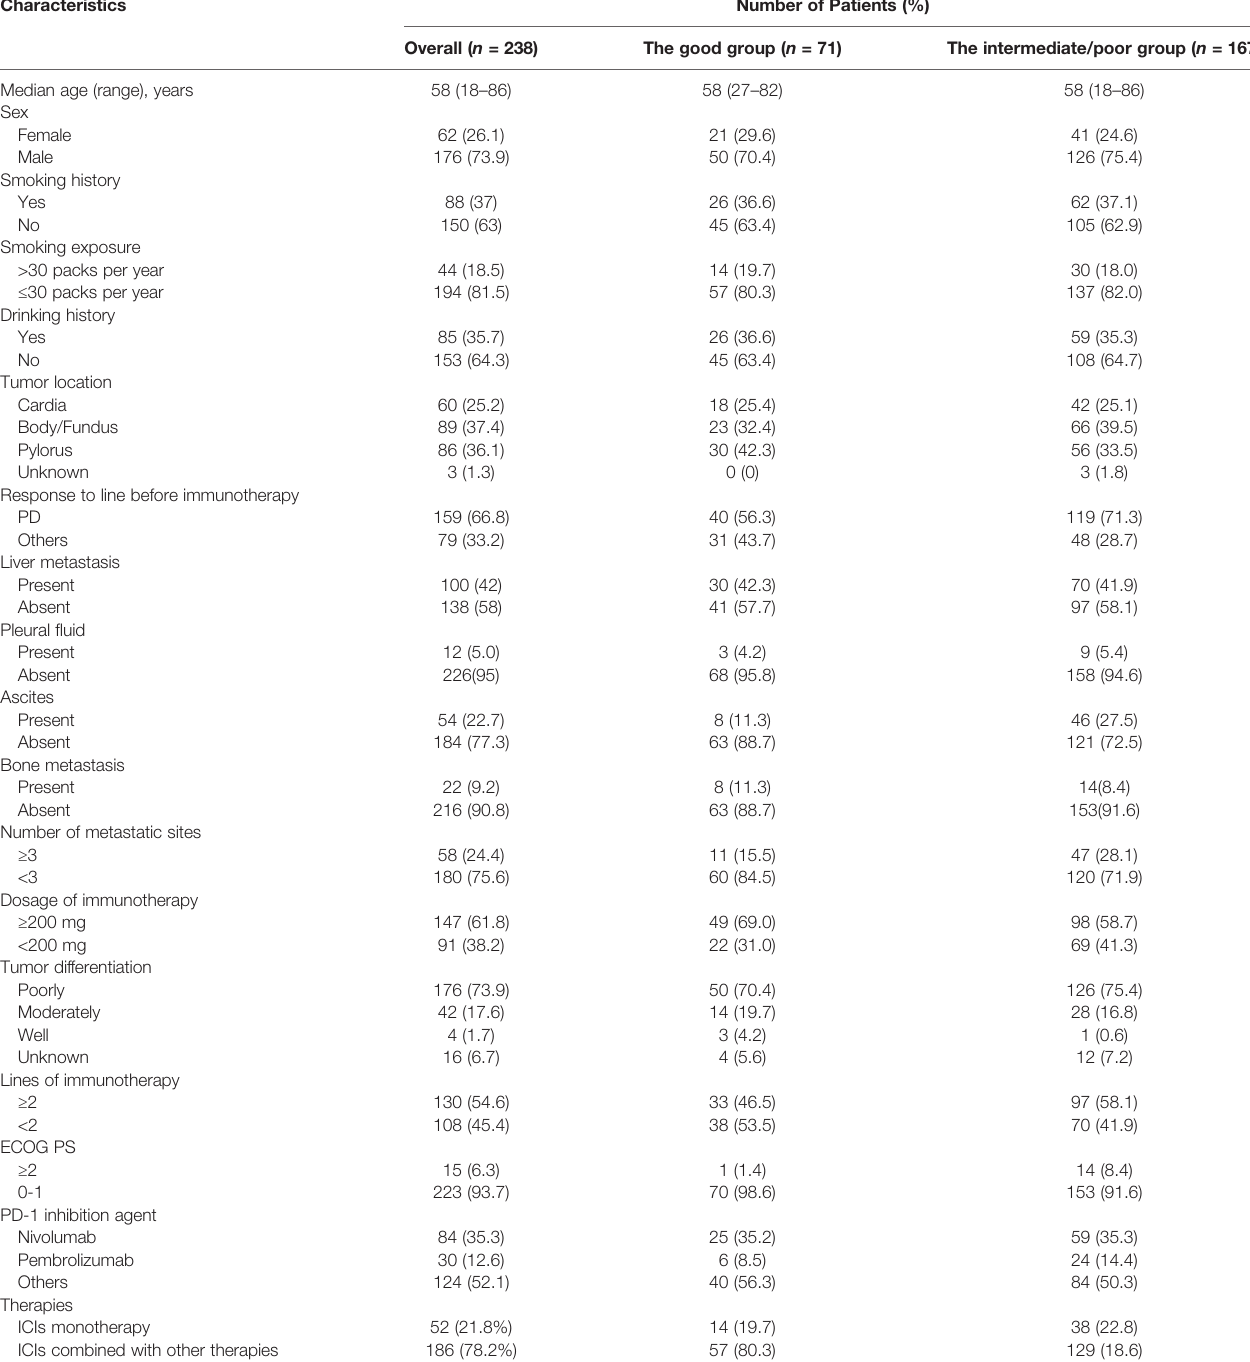
TABLE 1 | General data and clinical